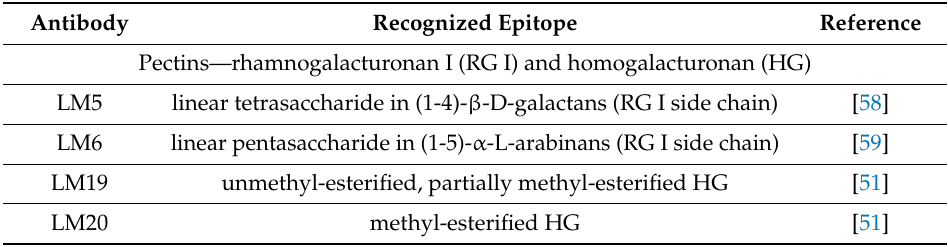
Table 1. List of the primary monoclonal antibodies used in the current study along with the epitopes that they